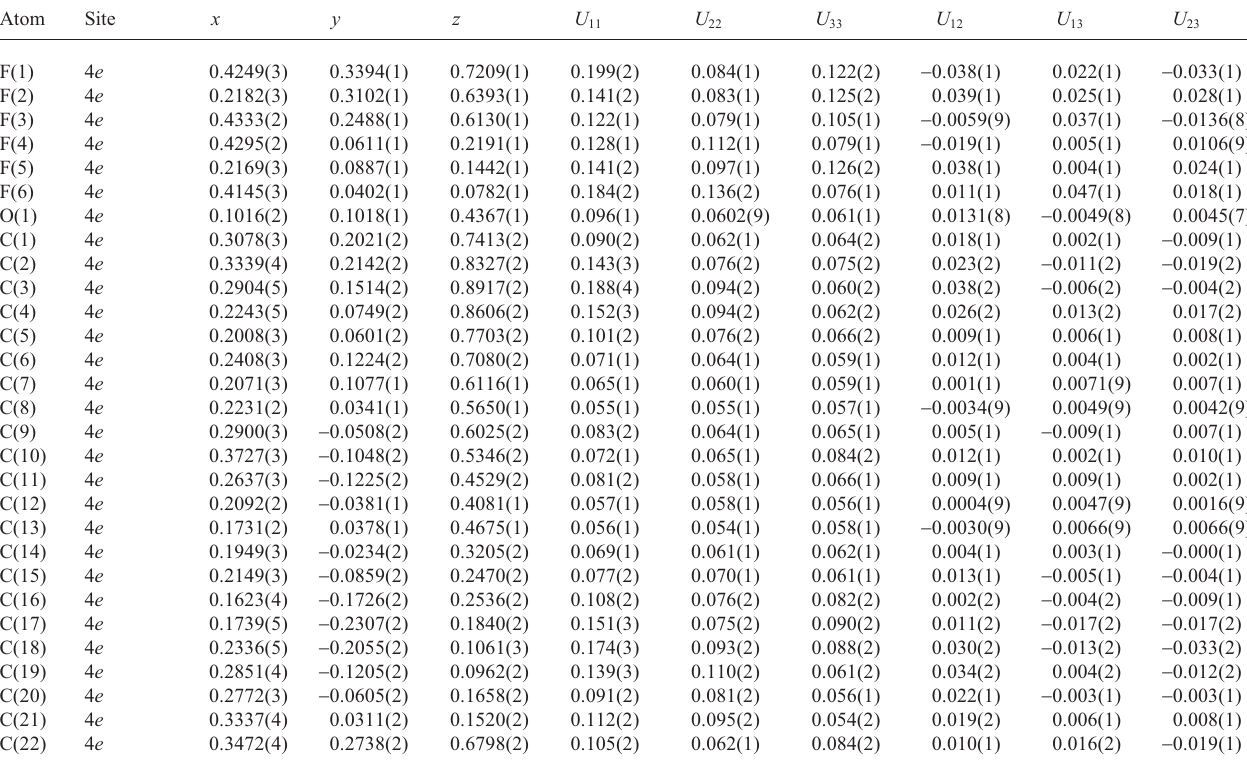
Table 3. Atomic coordinates and displacement parameters (in Å 2 )